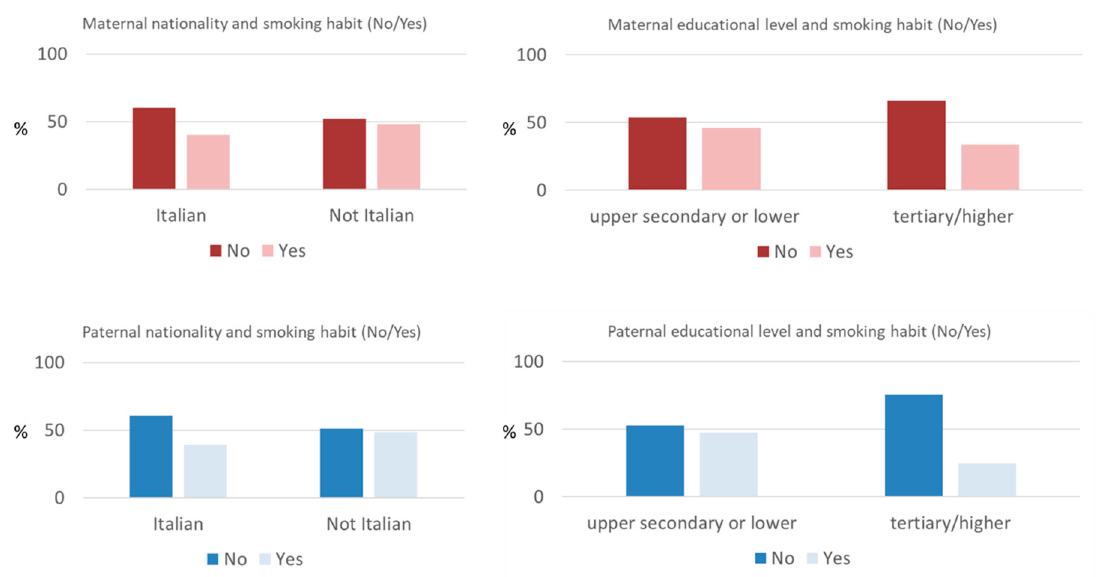
Figure 1. Association between paternal nationality and educational level and the prevalence of smoking habits. Statistically significant di ff erences in the prevalence of smoking habits have been recovered both for di ff erent educational levels of mother or father ( p = 0.022 and p < 0.001, respectively).